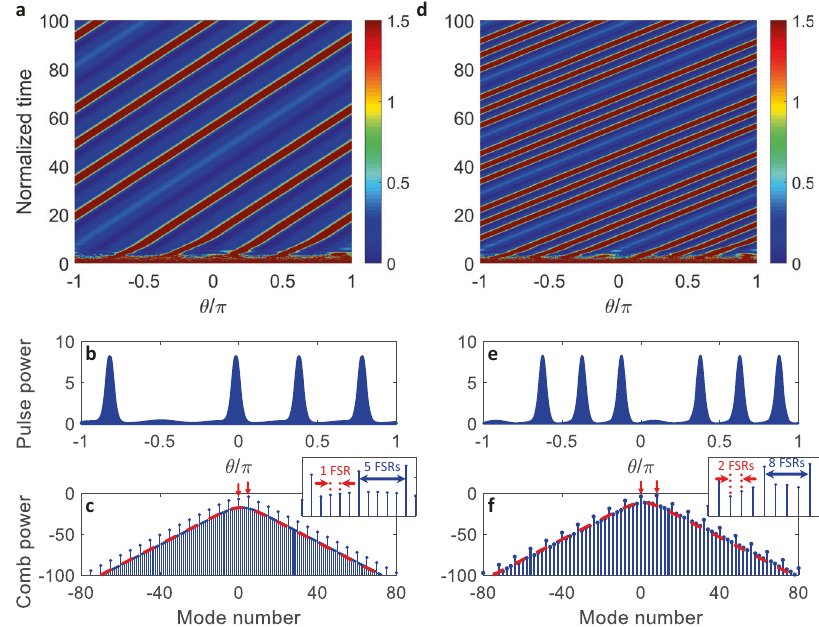
Fig. 3 Temporal long range order of the generated DTCs. Representative numerical integration results demonstrating temporal long-range order in two of the states in Fig. 1. Left panels a – c correspond to Fig. 1g, and right panels d – f to Fig. 1c. a , d Temporal evolution of pulse trains over 100 normalized times (200 cavity photon lifetimes and thousands of the driving period). Pulses are initialized through hard excitation, the horizontal axis is the angle around the resonator, and the vertical axis is the evolution time. Dark red lines denote soliton trajectories. b , e Snapshots of the pulse trains at the end of the integration time in a , d . c , f Frequency spectra (logarithmic scale) of the DTC states plotted in b , e . Each spectrum is centered on one of the pumped modes labeled 0, and the horizontal axis shows frequency normalized to the resonator FSR. Vertical red arrows mark the pumps and red dashed curves show hyperbolic secant envelopes. Insets are zoomed-in spectra around the center, showing the beatnote of the pumps (blue) and the separation of adjacent subharmonics (red). Generation of multiple subharmonics between the pumps is manifest. Numerical parameters match those of Fig. 2, with − σ 1 / κ = 4.